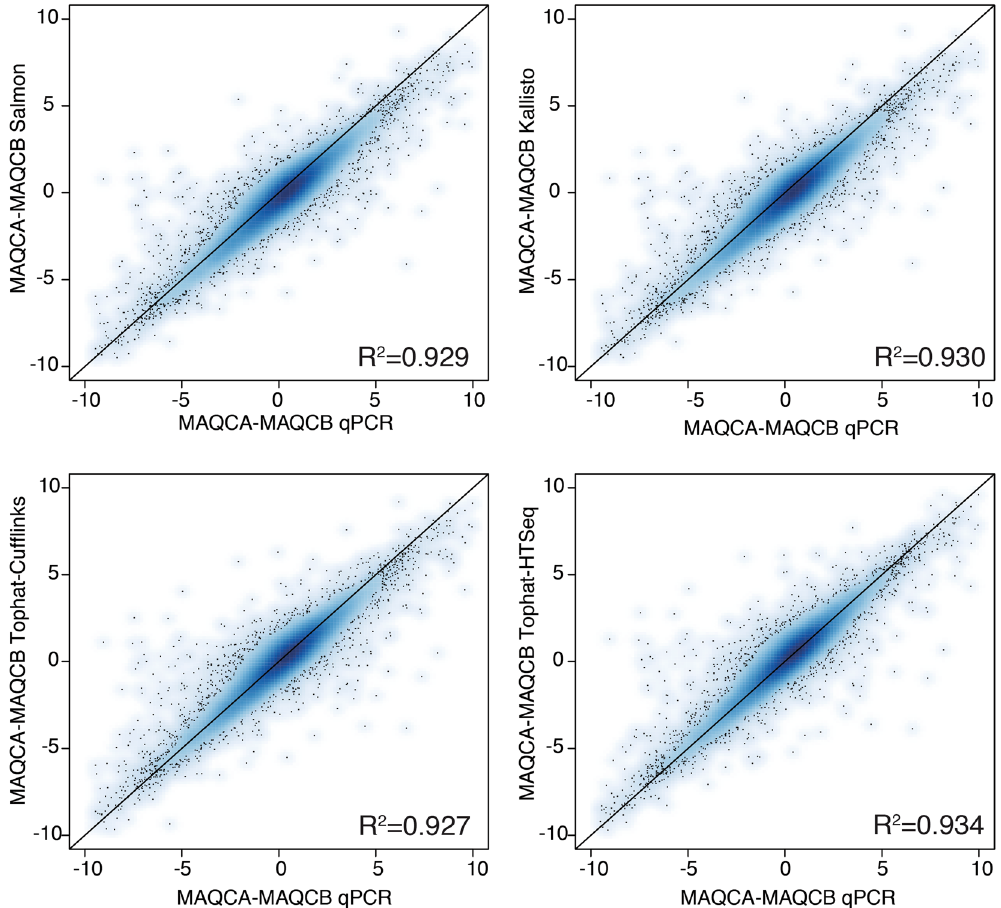
Figure 3. High fold change correlation between RT-qPCR and RNA-seq data for each workflow. The correlation of the fold changes was calculated by the Pearson correlation coefficient. Results are based on RNA- seq data from dataset